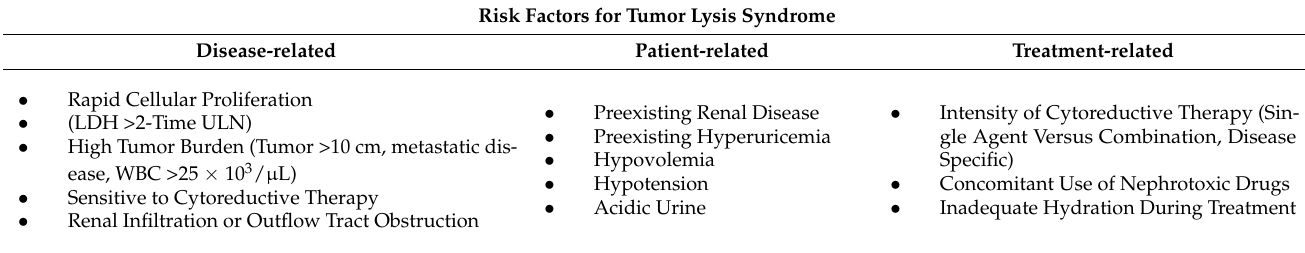
Table 5. Risk Factors for Tumor Lysis Syndrome.